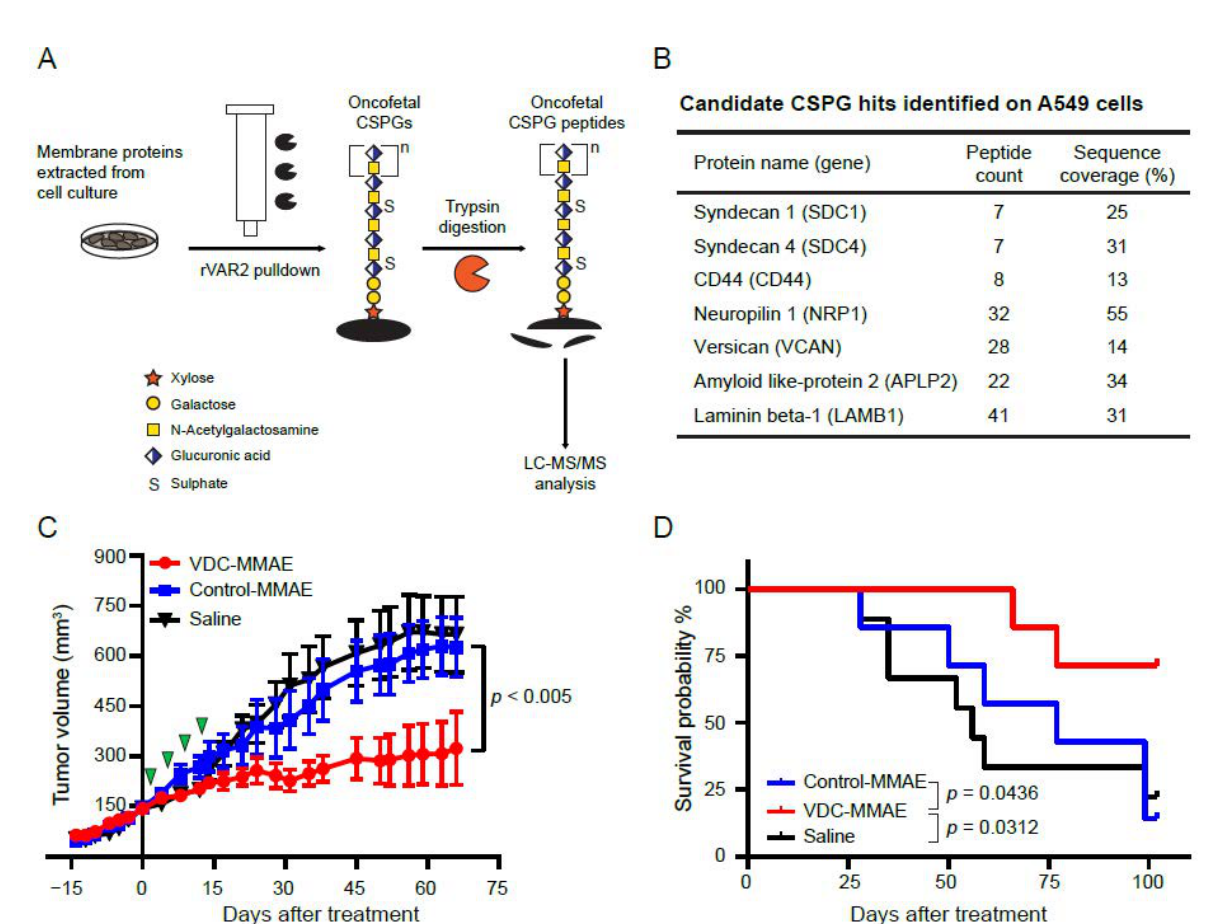
Figure 3. Proteomics analysis on A549 cells and effect of VDC-MMAE in A549 xenografts: ( A ) a workflow diagram for affinity purification and mass spectrometry analysis. ( B ) Oncofetal CS-modified CSPGs identified with rVAR2 pulldown and mass spectrometry on A549 cell line. ( C ) Comparison of tumor growth between VDC-MMAE and control groups. Treatment was administered intravenously twice per week for two weeks (green arrow heads) by intravenous injection in the tail vein as indicated. ( D ) Survival curve of VDC-MMAE and control groups from ( C ). Abbreviations: CSPG: chondroitin sulphate proteoglycan; rVAR2: recombinant malaria VAR2CSA protein; VAR2CSA: variant surface antigen 2-CSA; VDC: rVAR2 drug conjugate; MMAE: monomethyl auristatin E.